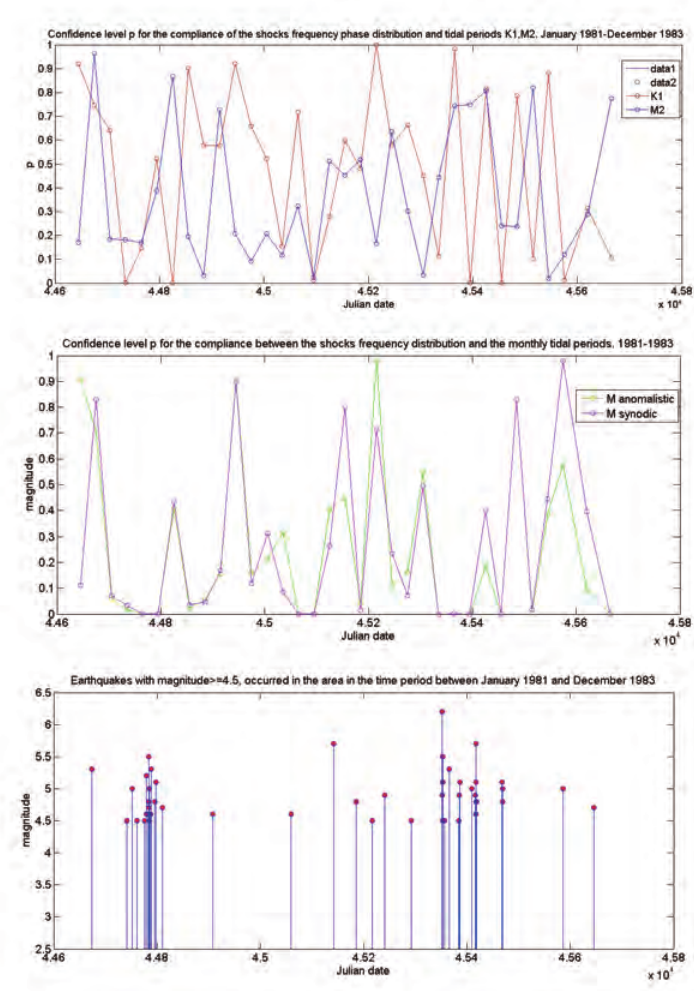
Figure 10. Confidence levels for compliance between the frequency distribution of the shock occurrence and (a) K1, M2 tidal periods. (b) M- anomalistic and M-synodic periods. (c) Earthquakes with magnitudes $ 4.5 for the time from January 1981 to December 1983.